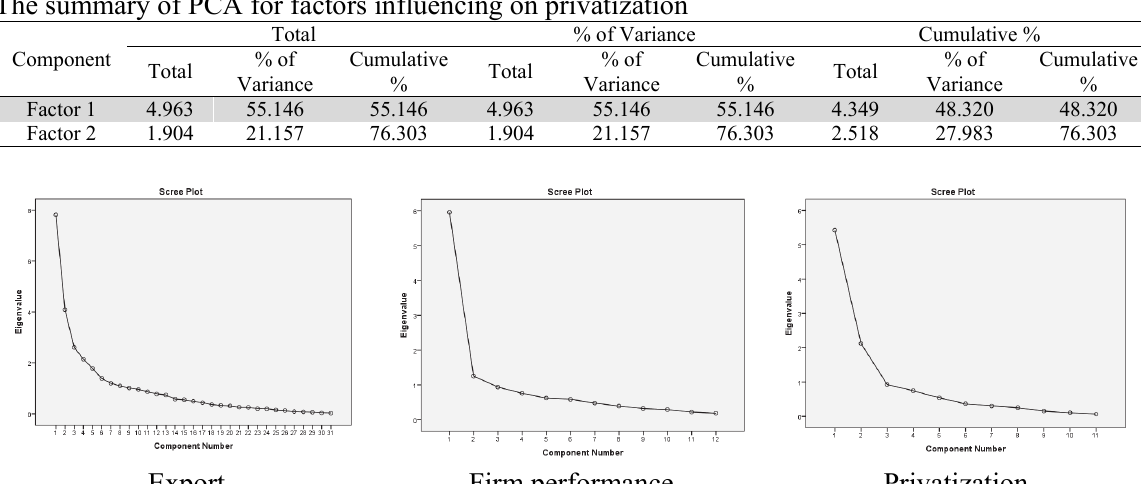
Fig. 2. The results of Scree plot for three parts of the